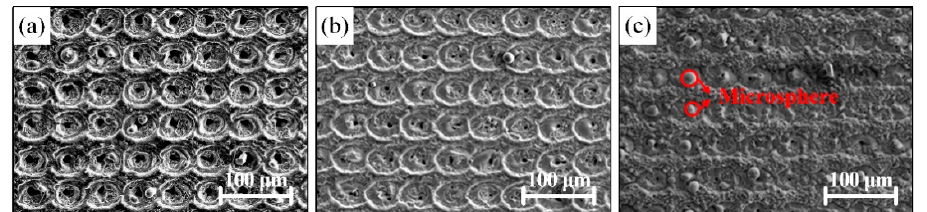
Figure 6. Microdimple structural morphology under different scanning speeds: ( a ) 2 mm/s; ( b ) 12 mm/s; ( c ) 20 mm/s.